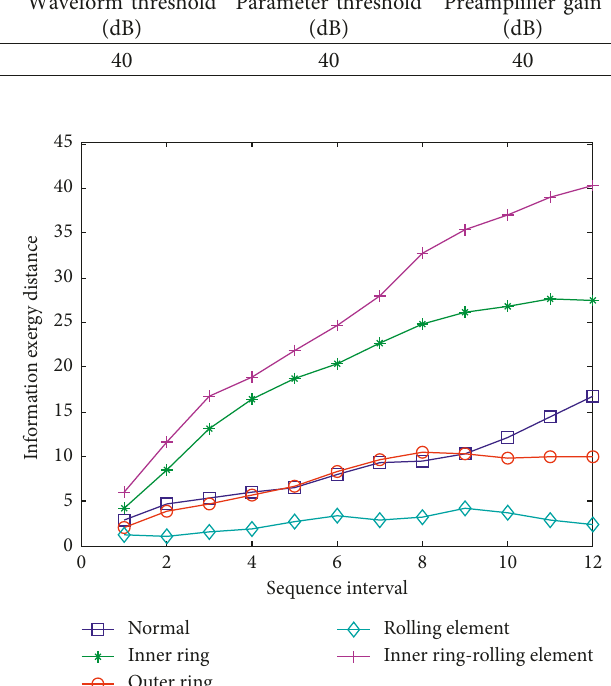
Figure 5: Information exergy distance of the rolling element fault.